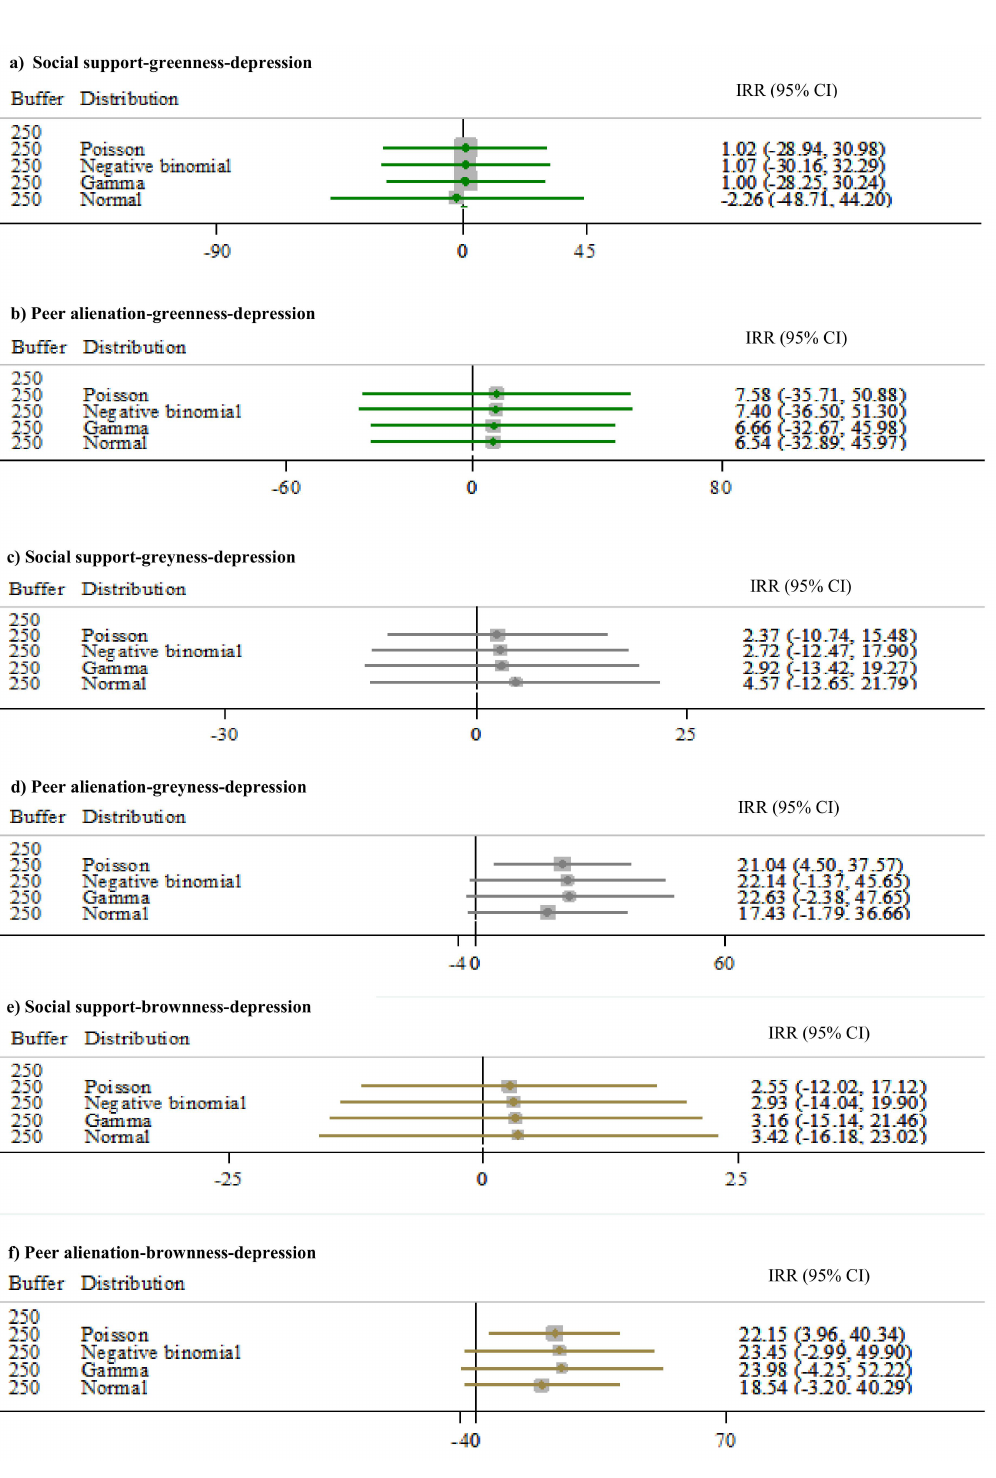
Figure 4. Social support and peer alienation as pathways between greenness, grayness, and brownness and depression (as continuum), in 250 m buffer. ( a ) Social support–greenness–depression. ( b ) Peer alienation –greenness–depression. ( c ) Social support–grayness–depression. ( d ) Peer alienation–grayness–depression. ( e ) Social support–brownness–depression. ( f ) Peer alienation–brownness–depression. IRR (95% CI). Note: Buffer indicates distances in meters around the geocoded address of residence of each study participant. Distribution indicates the distribution in which depression was modeled. When the normal distribution was assumed, the values of depression were log transformed. IRR are incidence rate ratios. CI is confidence interval. All models were adjusted by Age, Sex, Healthy-food index, Physical-Activity index, Body mass index, Household income, Adverse Childhood Experiences, Social support index, and Peer alienation